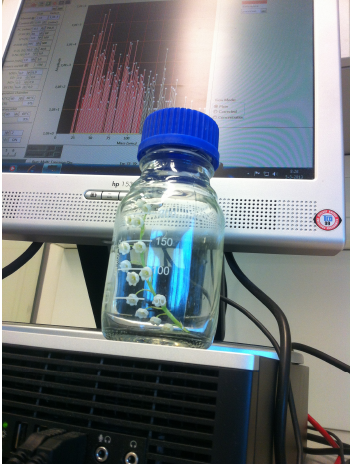
Figure 1. Photograph of the sample flask and example mass spectrum of the flowers of C. majalis